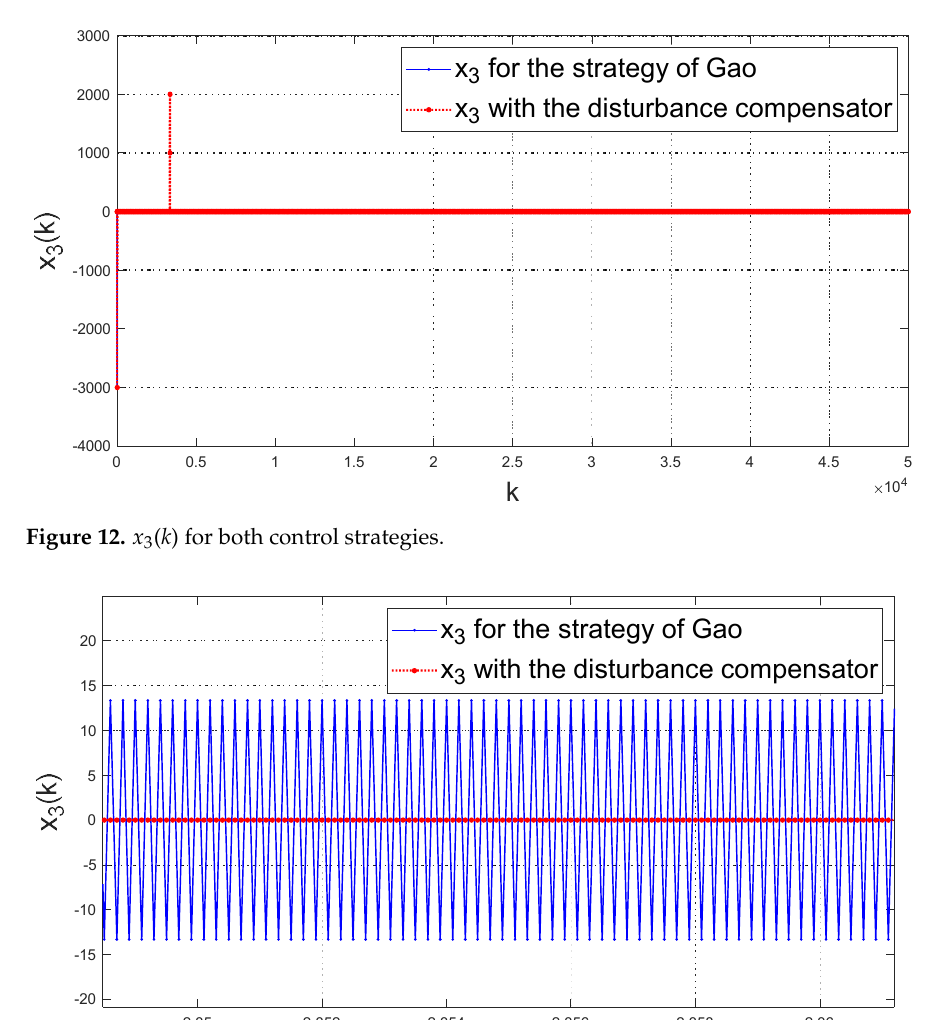
Figure 11. x 2 ( k ) for both control strategies in the sliding phase (zoomed).